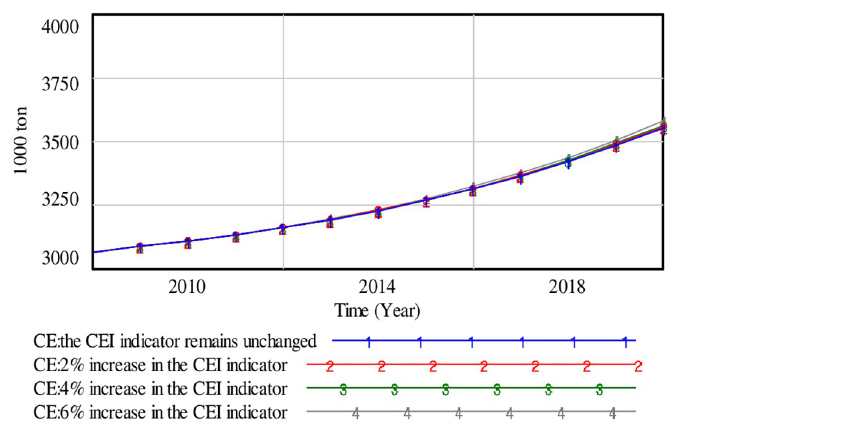
Fig 5. Changes in the sensitivity of model triggered by the CEI indicators.